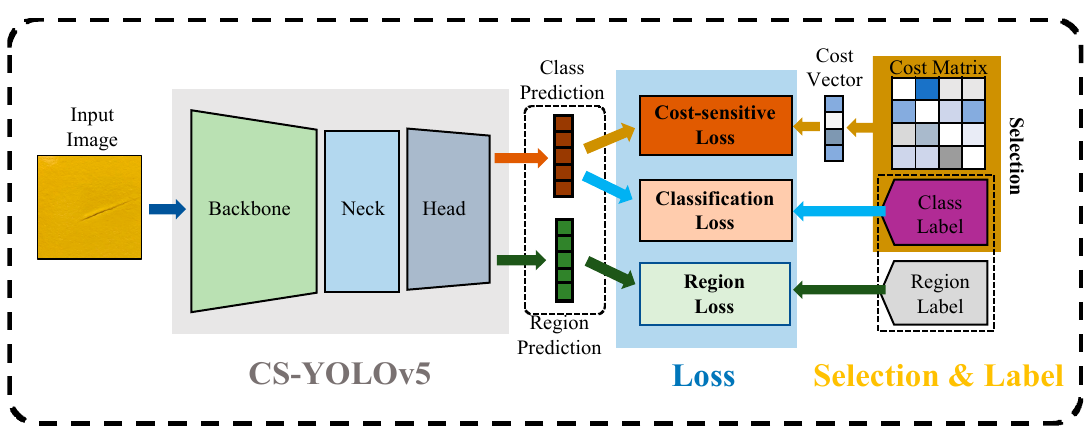
Figure 1. CS-YOLOv5 model and classification loss structure.